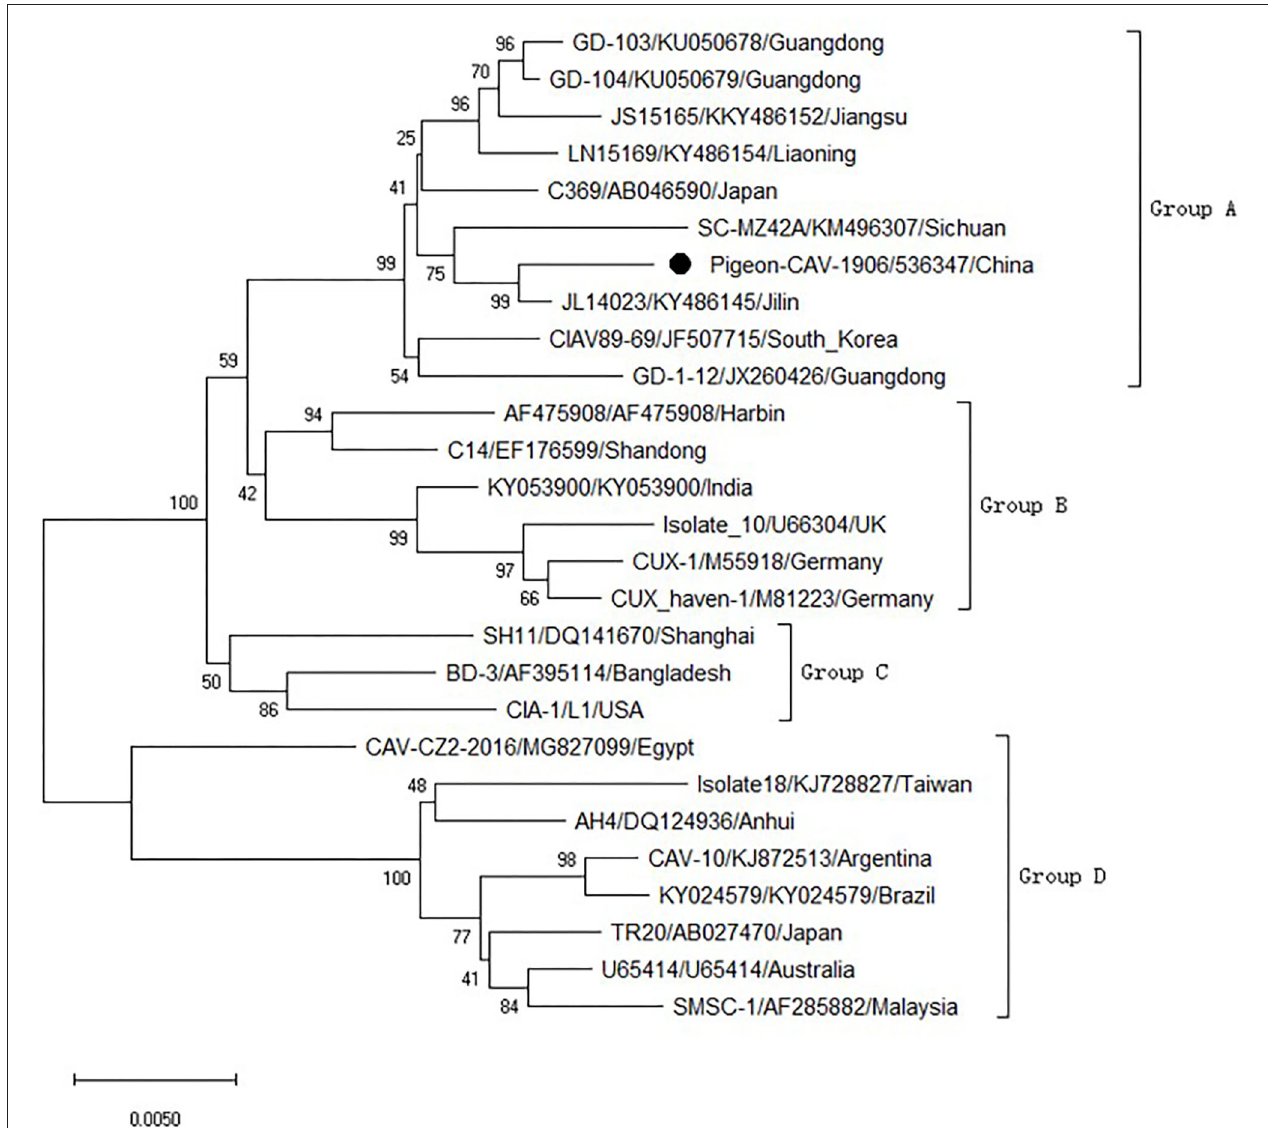
FIGURE 2 | Phylogenetic tree for the genome of Pigeon-CIAV-1906. The phylogenetic tree was generated using the neighbor-joining method (1,000 bootstraps) with MEGA6.